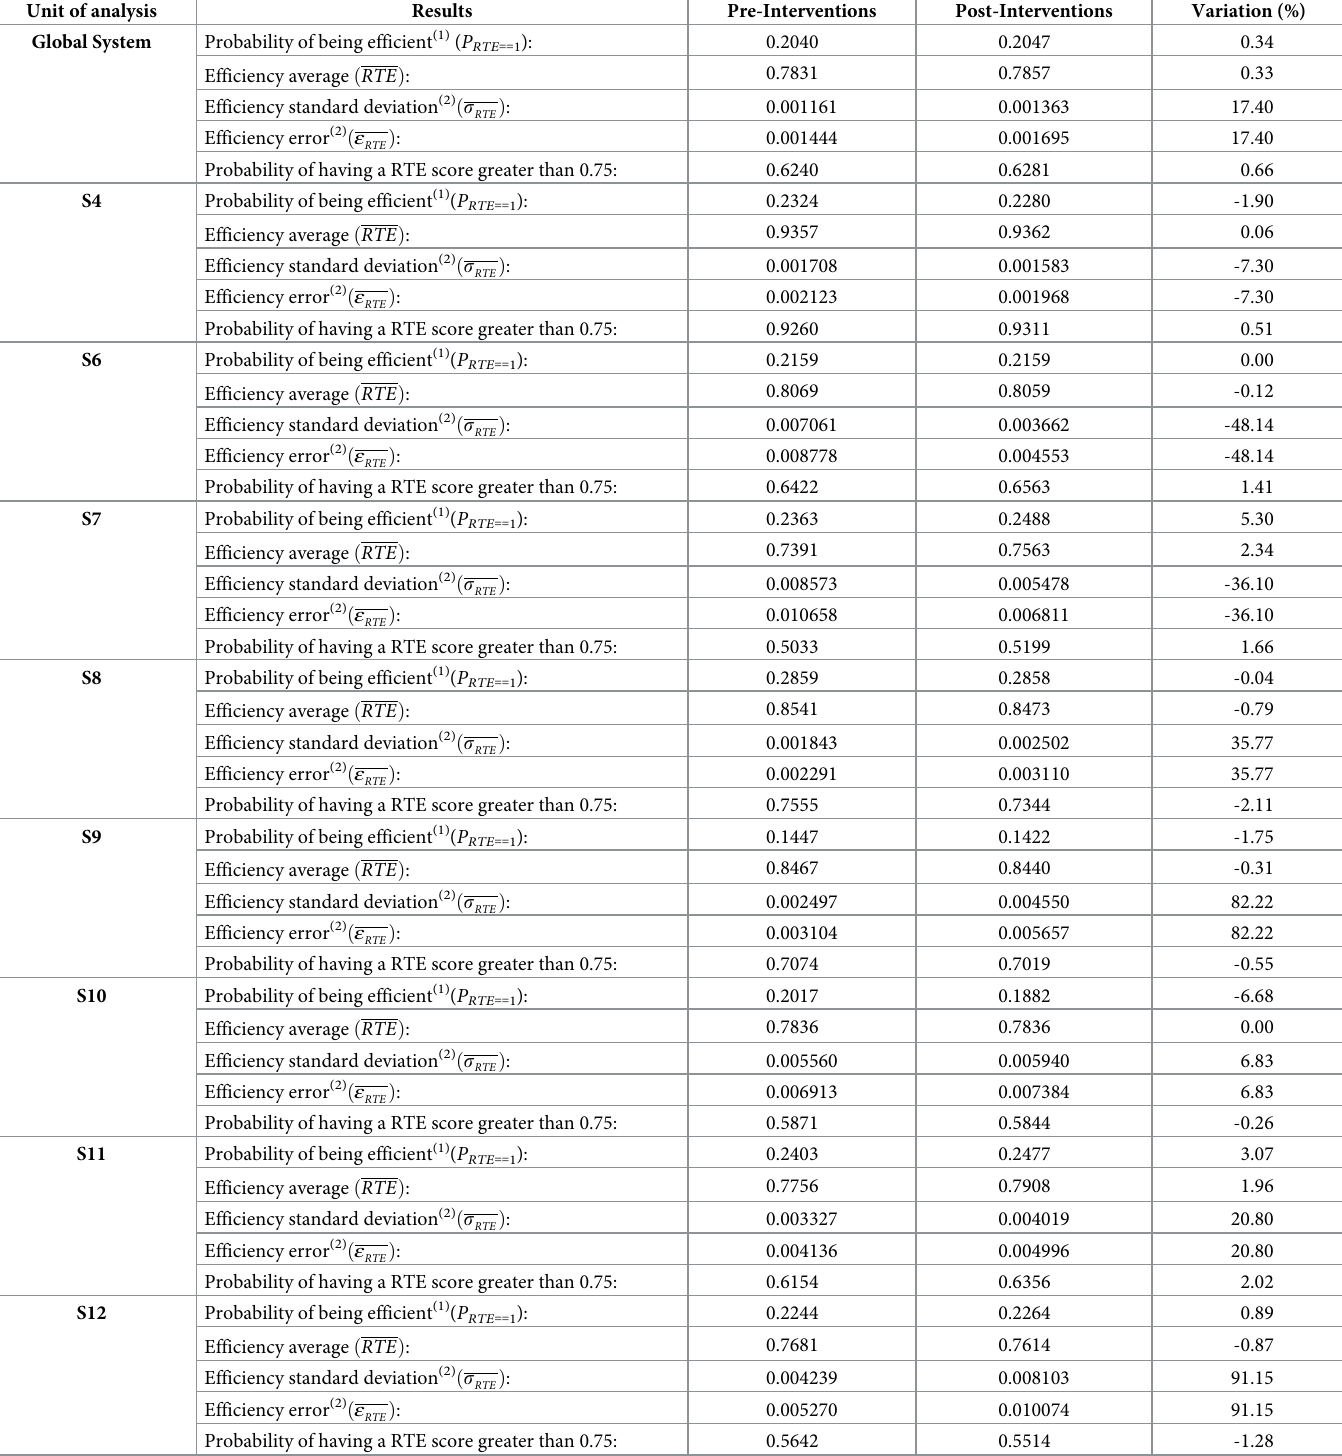
Table 3. Impact of the meso-interventions (input-oriented results). Unit of